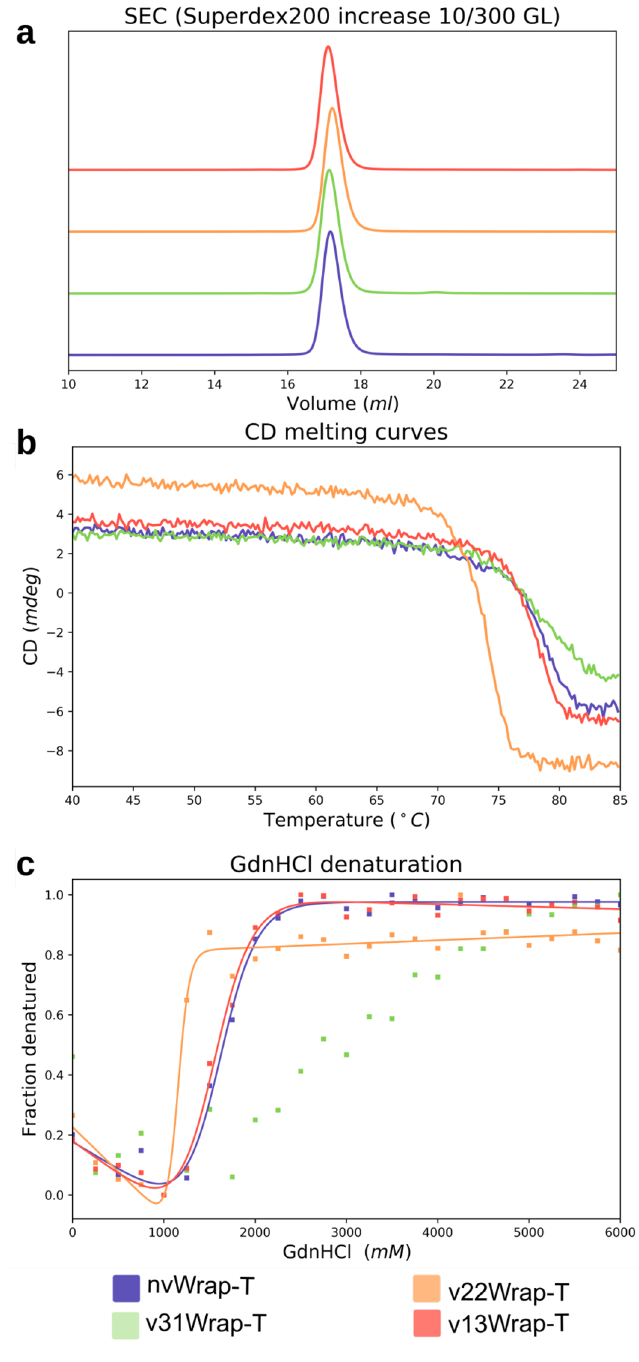
Figure 3. Purification and stability data for the WRAP-T proteins. Normalized analytical size exclusion indicates all proteins have the same hydrodynamic volume ( a ). Measuring the CD signal at 218 nm while increasing the temperature shows the melting point of each protein see data Table 1 ( b ). The fluorescent signal of tryptophan was followed at 320 nm this allows for the calculation of fraction denatured under increasing Guanidine hydrochloride concentration ( c